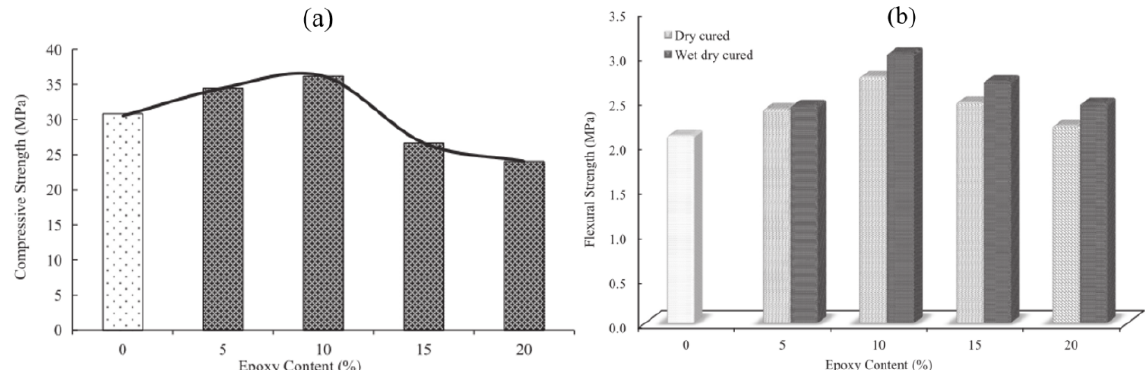
Figure 1. The mechanical strength of epoxy mortar: ( a ) Relationship between compressive strength and epoxy content for wet–dry curing; ( b ) Relationship between flexural strength and epoxy content for wet curing and wet–dry curing [37]. (Adapted and reprinted with permission from ref. [37], © 2015, Construction and Building Materials .).